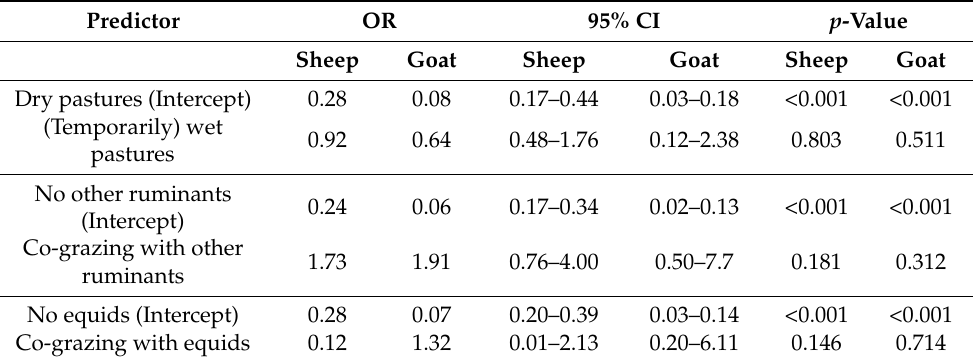
Table 9. Results of simple logistic regressions: predictors for patent D. dendriticum infections on sheep and goat